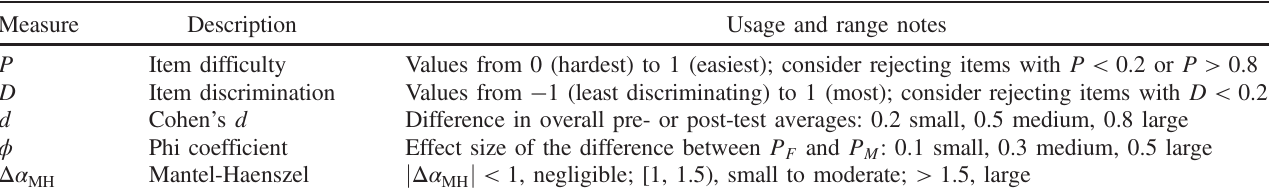
TABLE I. Summary of item statistics and effect sizes reported in this study. Measure Description